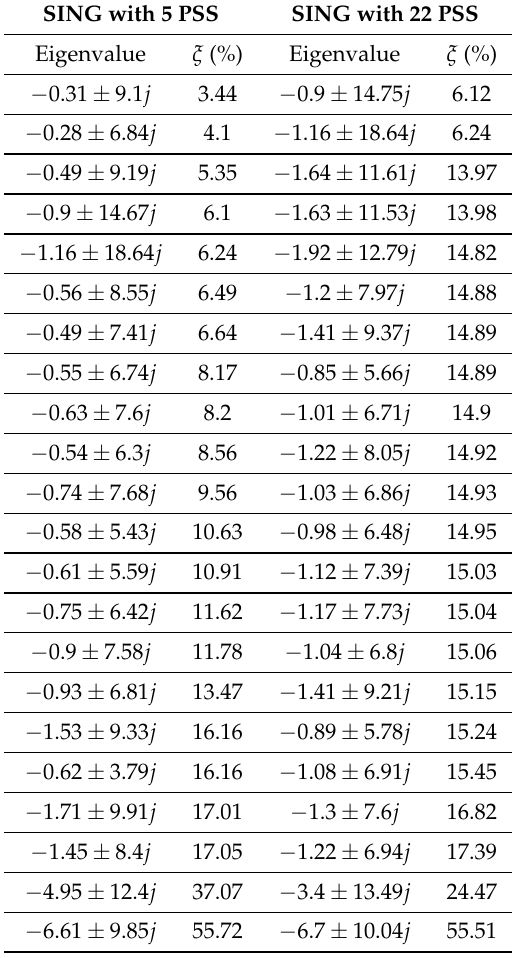
Table 6. Eigenvalues associated with the electromechanical variables of the SING. SING with 5 PSS SING with 22